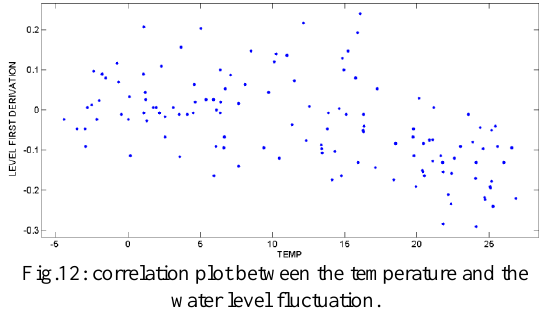
Fig. 9. Urmiah Lake water level total and seasonal variations (1998-2006).